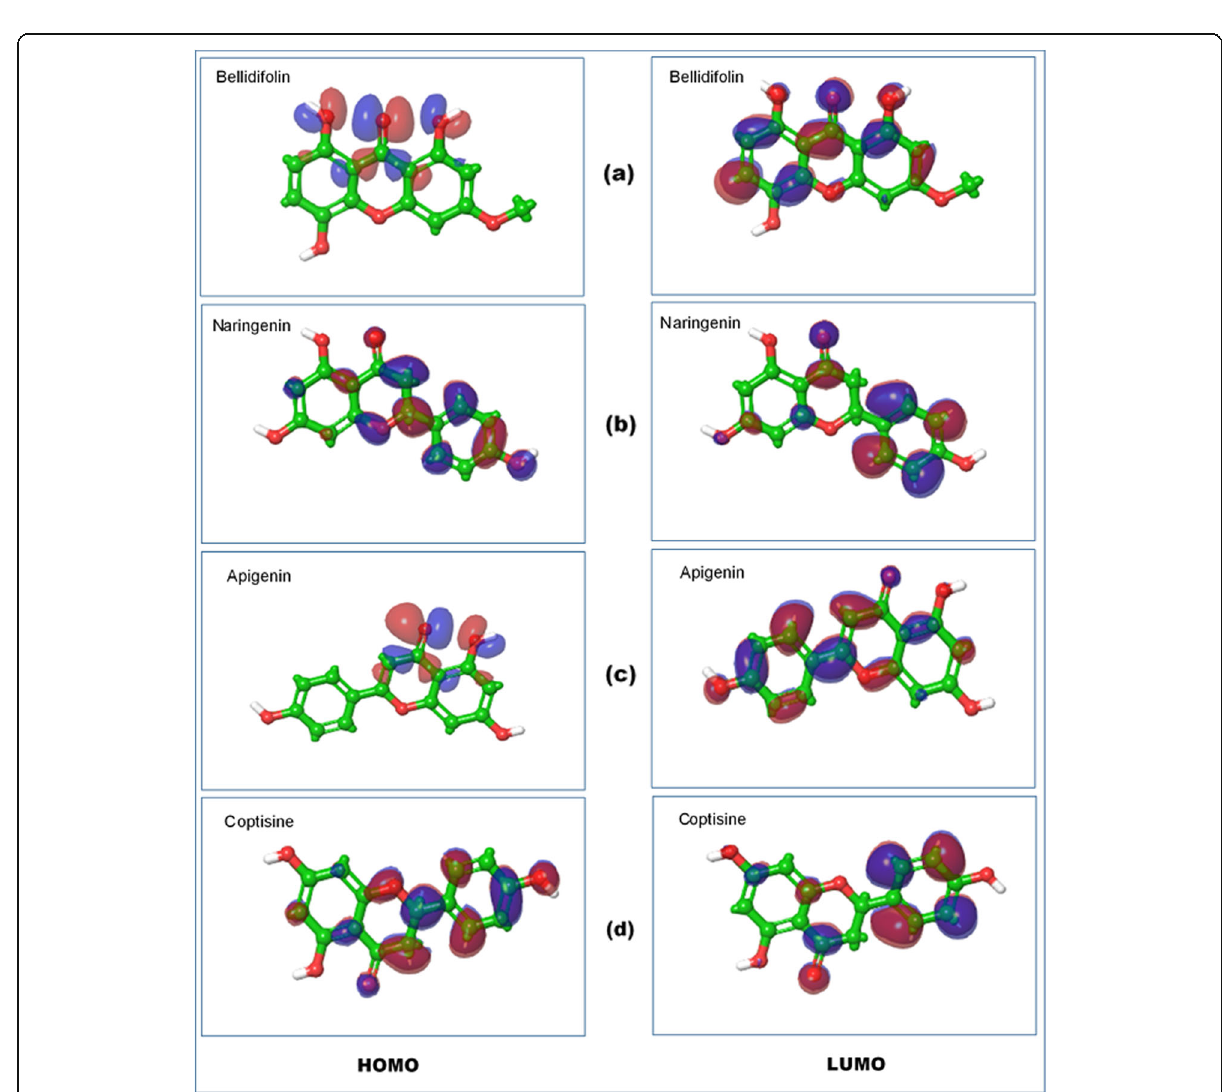
Fig. 3 The results of HOMO and LUMO studies; a bellidifolin, b naringenin, c apigenin, and d